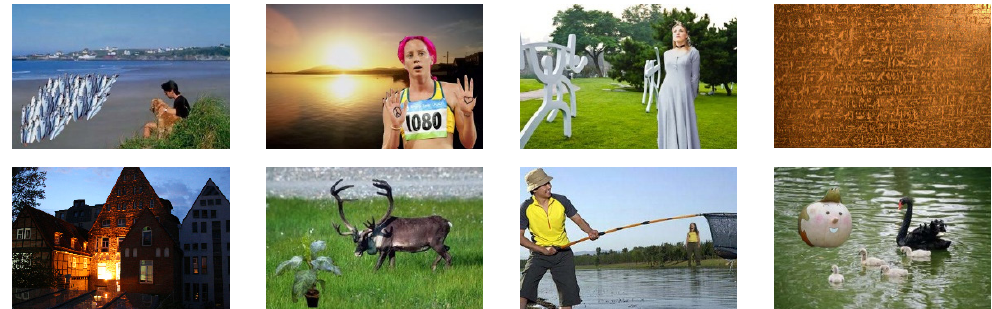
Figure 4. Examples of different kinds of image forgeries.